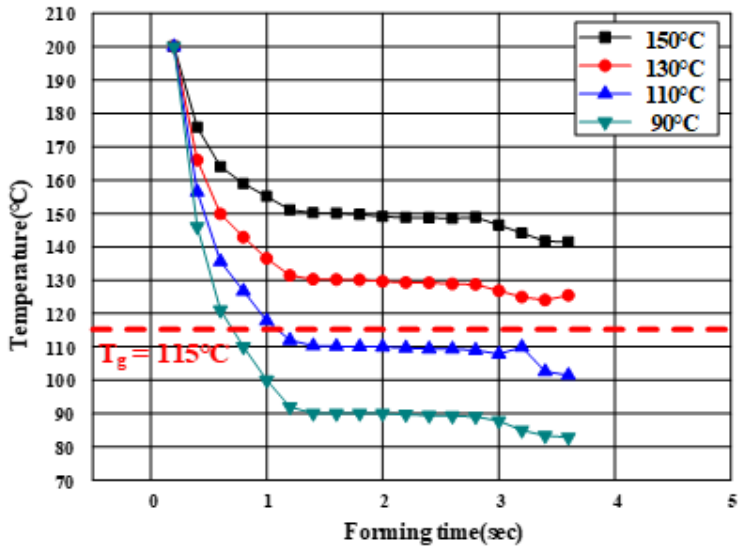
Figure 8. Temperature histories of laminate during the PCM process.